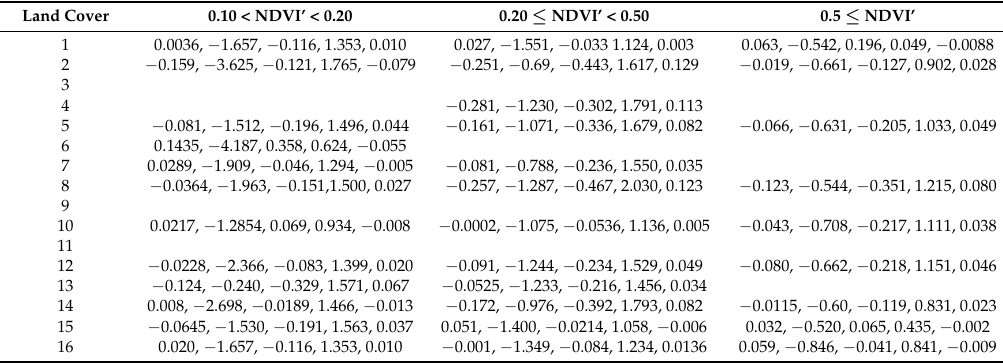
Table 6. Surface Reflectance Coefficients for 0.67 µ m for MAM.